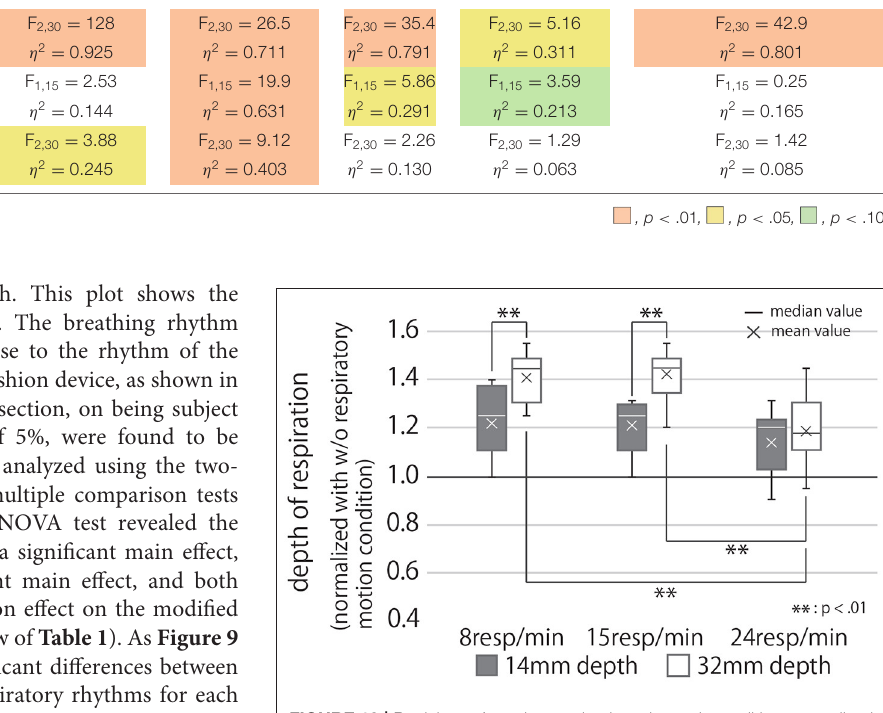
FIGURE 10 | Participants’ respiratory depth under each condition, normalized with the condition of no respiratory motion. If the value of the graph is greater than 1, it means that the depth of the participants’ breathing was greater than when they were holding the device that did not present the respiratory